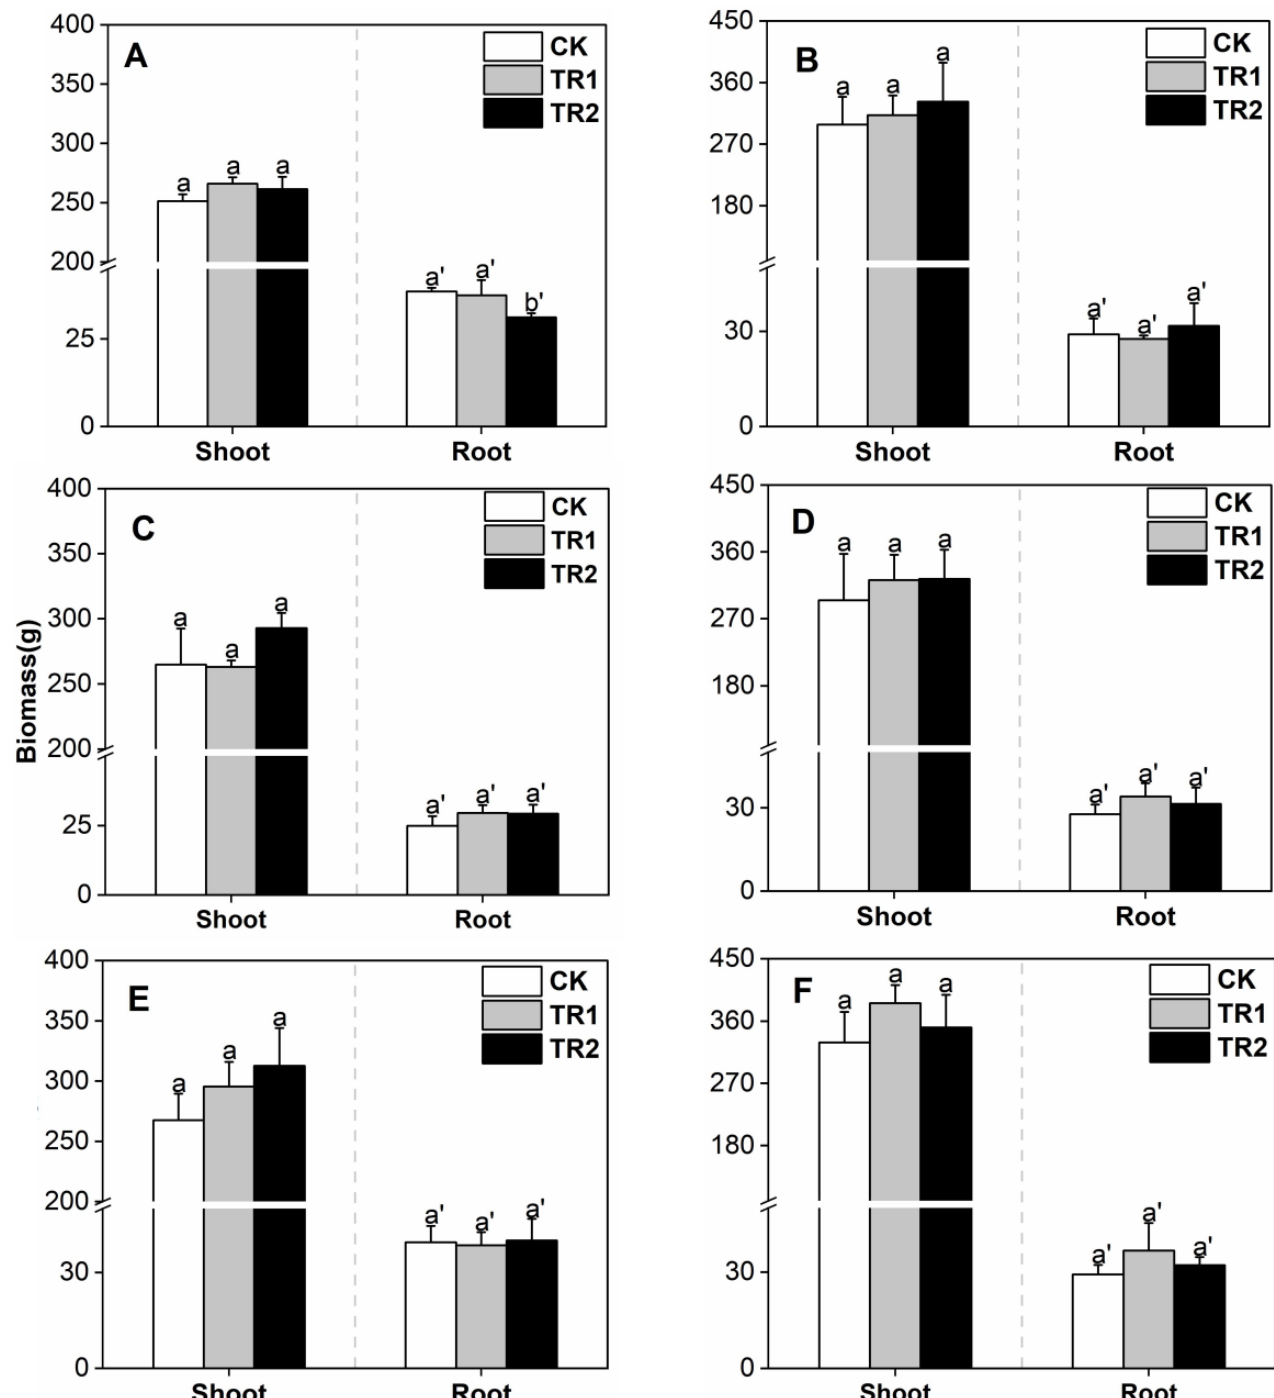
Figure 4. Oil sunflower biomass. ( A ) First period intercropping papaya, ( B ) Second period intercropping papaya, ( C ) First period intercropping grapefruit, ( D ) Second period intercropping grapefruit, ( E ) First period intercropping fig, ( F ) Second period intercropping fig. The different letters above the column indicate the significant differences among different treatments at p < 0.05.